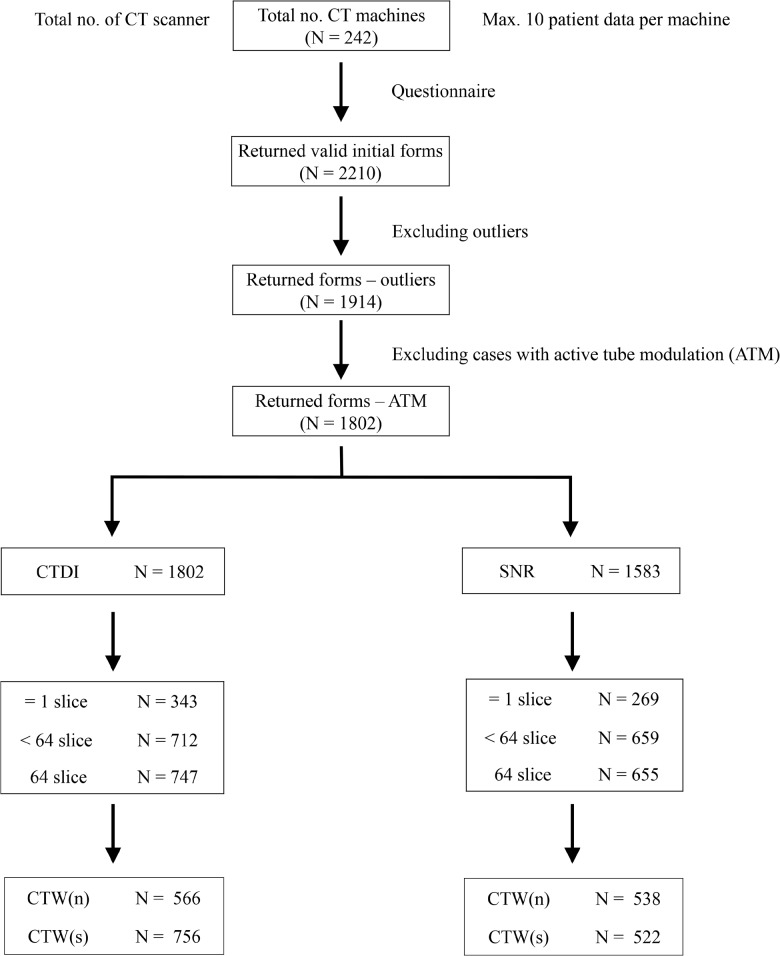
The work flow diagram demonstrates how the raw data from the questionnaire was rearranged into the final dataset.